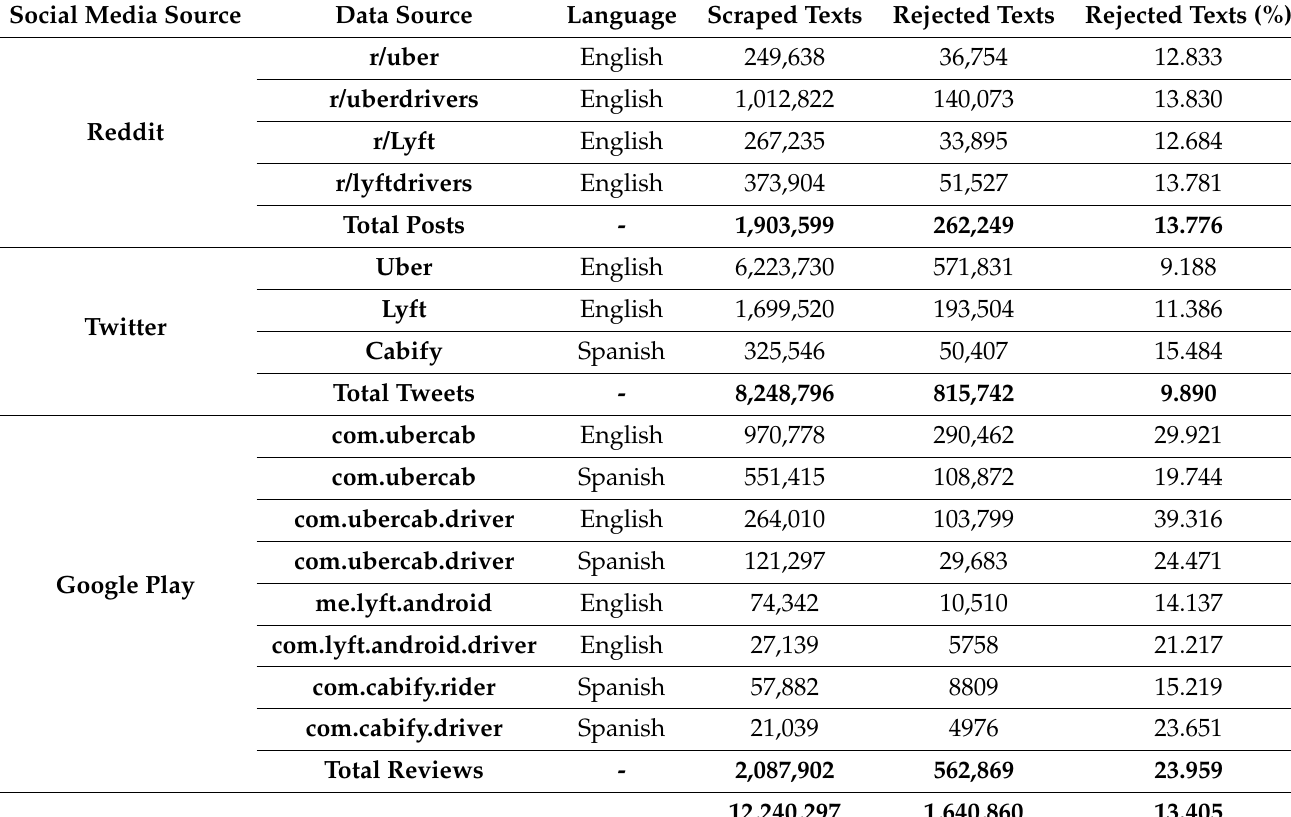
Table 4. Total collected and validated